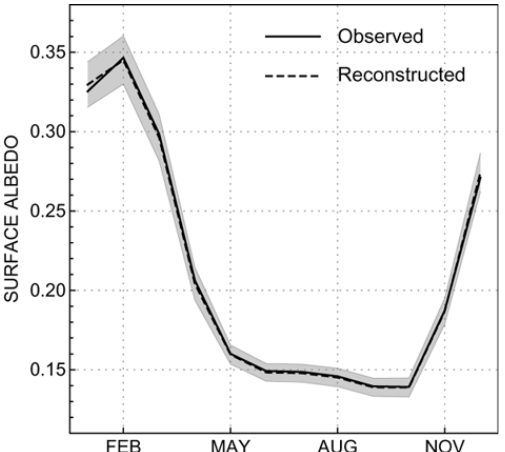
Fig. 4. Monthly mean albedo in North America and Eurasia (the region of study is indicated in Fig. 2a). Solid and dashed lines indi- cate the observed and the reconstructed albedo values, respectively. Shaded area illustrates the ± 1 mean absolute error as departures from the reconstructed net albedo, calculated between the recon- structed and the observed values of the ensemble of grid cells within the region